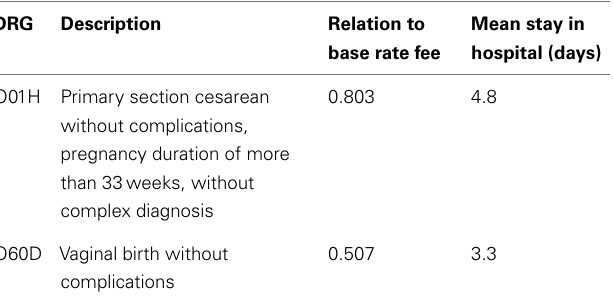
Table 1 | DRGs in Germany for vaginal and cesarean births without